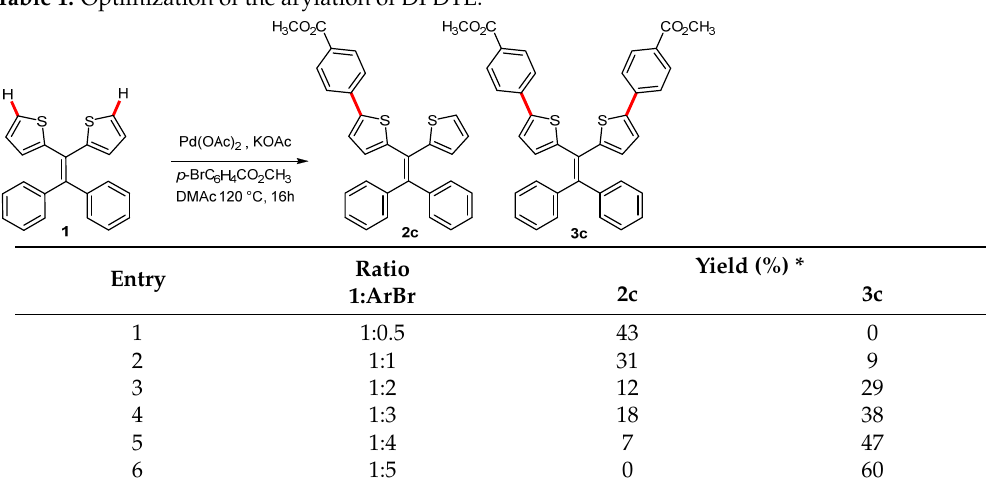
Table 1. Optimization of the arylation of DPDTE.